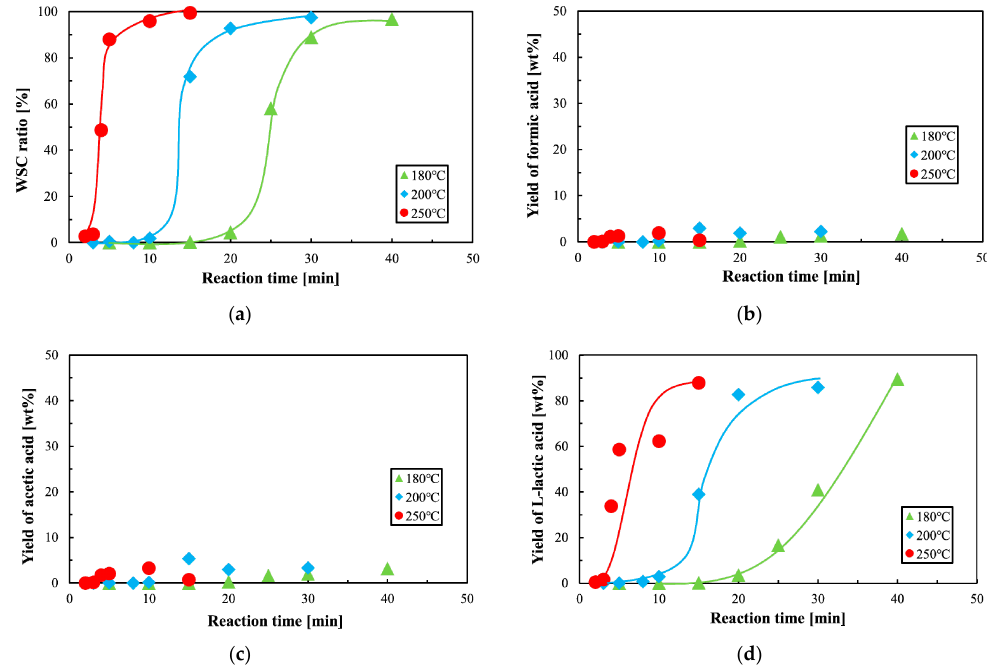
Figure 6. Kinetic analysis of the water-soluble content (WSC) yield. ( a ) WSC ratio of polylactic acid (PLA) in saturated water pressure; ( b ) yield of methanoic acid according to reaction time and temperature; ( c ) yield of acetic acid according to reaction time and temperature; and ( d ) yield of L -lactic acid according to reaction time and temperature.